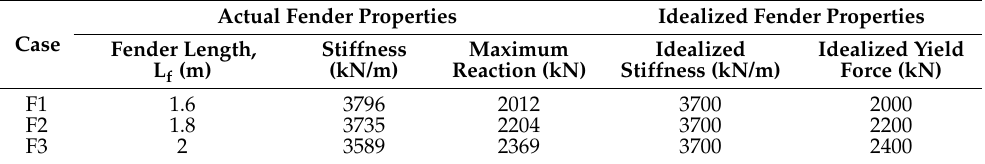
Table 4. Parameters of the fenders.